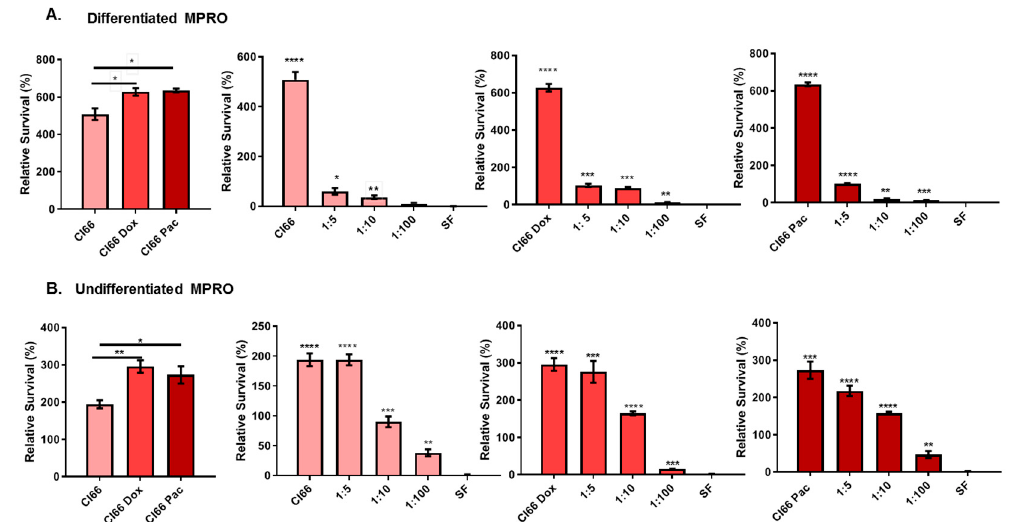
Figure 2. The chemotherapy-resistant cell lines Cl66-Doxorubicin (Cl66-Dox), and Cl66-Paclitaxel (Cl66-Pac). supernatants enhanced neutrophil survival. ( A ) Bar graph showing higher viability of di ff erentiated MPRO in the supernatant of chemotherapy-resistant cell lines (Cl66-Dox and Cl66-Pac) in comparison with thee supernatant of parental Cl66 cells. Similarly, bar graphs showing an increase in the survival of di ff erentiated neutrophils with an increase in the gradient of the supernatant of Cl66, Cl66-Dox, and Cl66-Pac cells. ( B ) Bar graph showing higher viability of undi ff erentiated MPRO in the supernatant of chemotherapy-resistant cell lines (Cl66-Dox and Cl66-Pac) in comparison with supernatant of parental Cl66 cells. Similarly, bar graphs show an increase in the survival of undi ff erentiated neutrophils with an increase in the gradient of the supernatant of Cl66, Cl66-Dox, and Cl66-Pac cells. The values are shown as mean ± SEM. The data are representative of three independent experiments performed in triplicate with similar results. Unpaired Student’s t -test; * p < 0.05; ** p < 0.01; *** for p ≤ 0.001; **** for p ≤